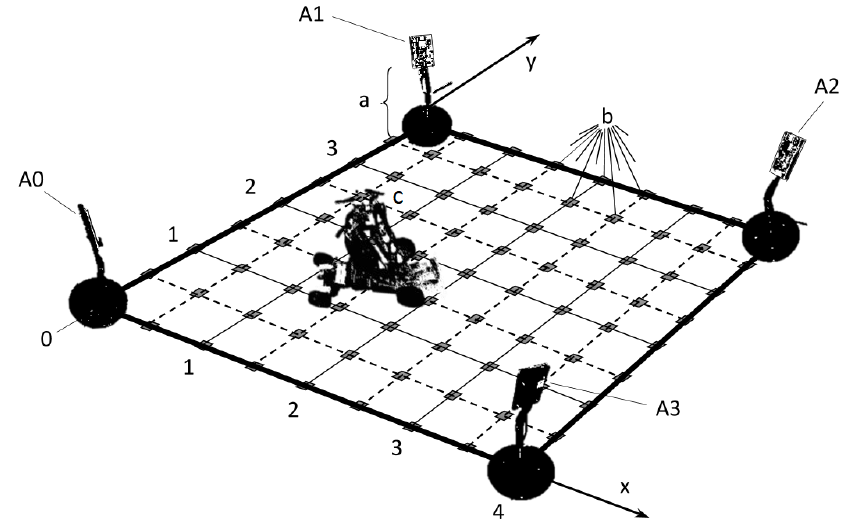
Figure 1. Not-to-scale diagram of the 4 × 4 m 2 2D IPS being studied: (a) adjustable stands for the transmitting anchor antennas (A0–A3); (b) measurement points distributed every 50 cm in each direction; and (c) mobile stand for the object to be